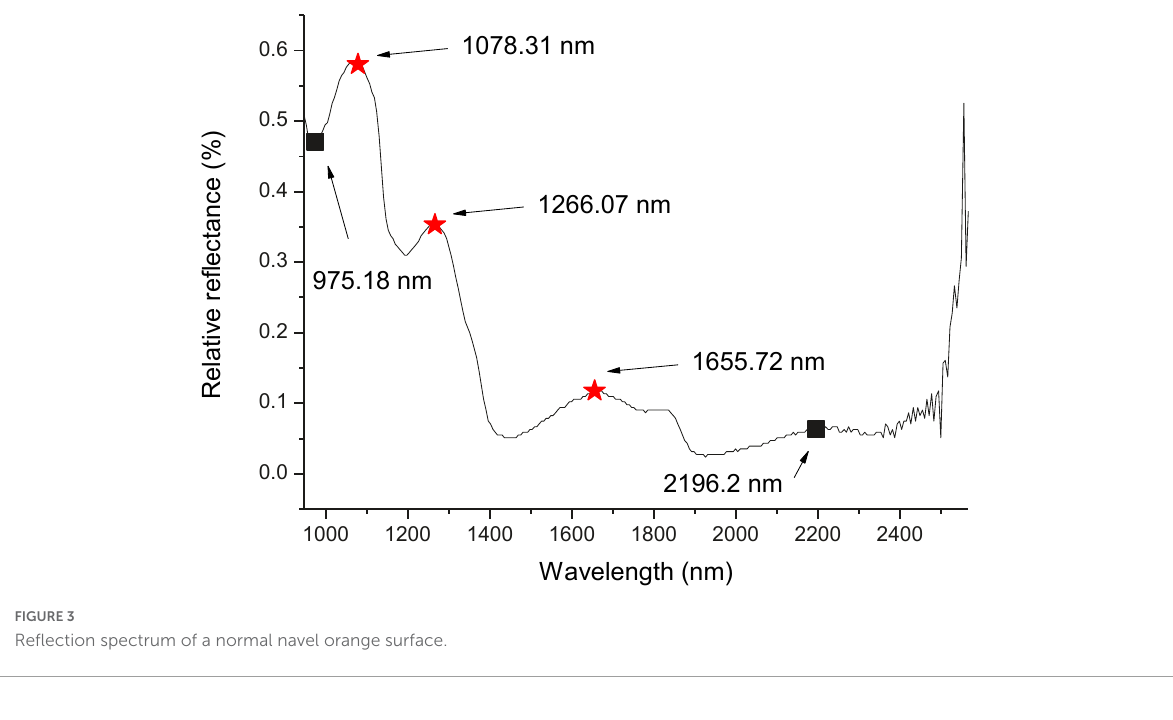
TABLE 1 Spectra number of each category.